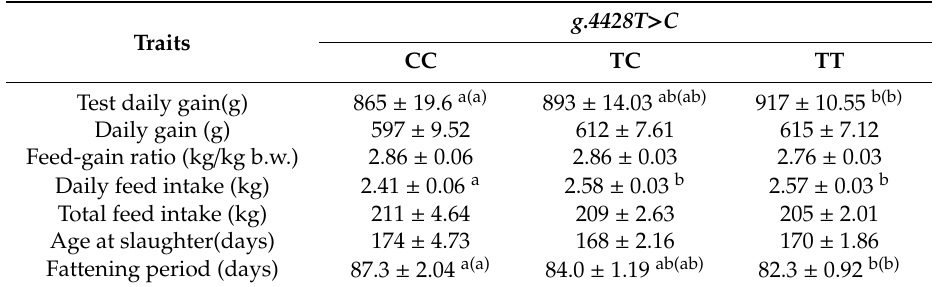
Table 8. Di ff erences in growth and fattening traits between pigs with di ff erent genotypes at the locus g.4428T > C (LSM ± SE).